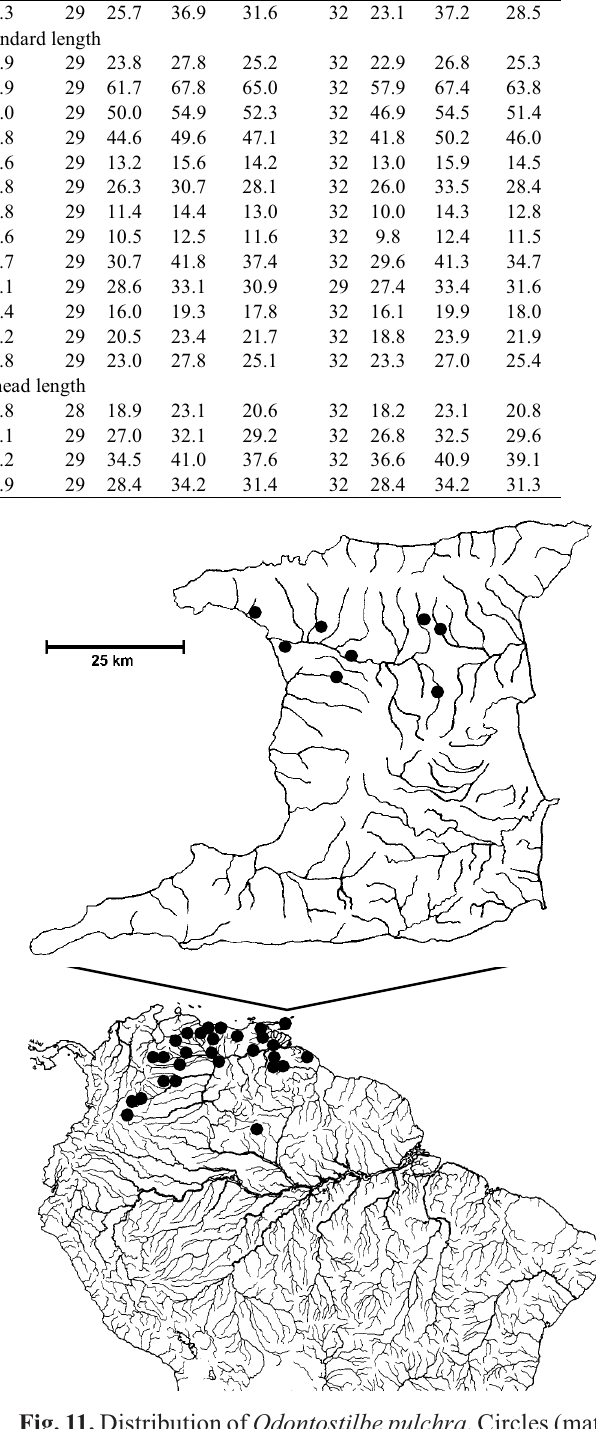
Fig. 11. Distribution of Odontostilbe pulchra . Circles (mate- rial examined, symbols can represent more than one lot, and more than one locality). In detail Trinidad map, modified from American Geographical Society of New York (1957).